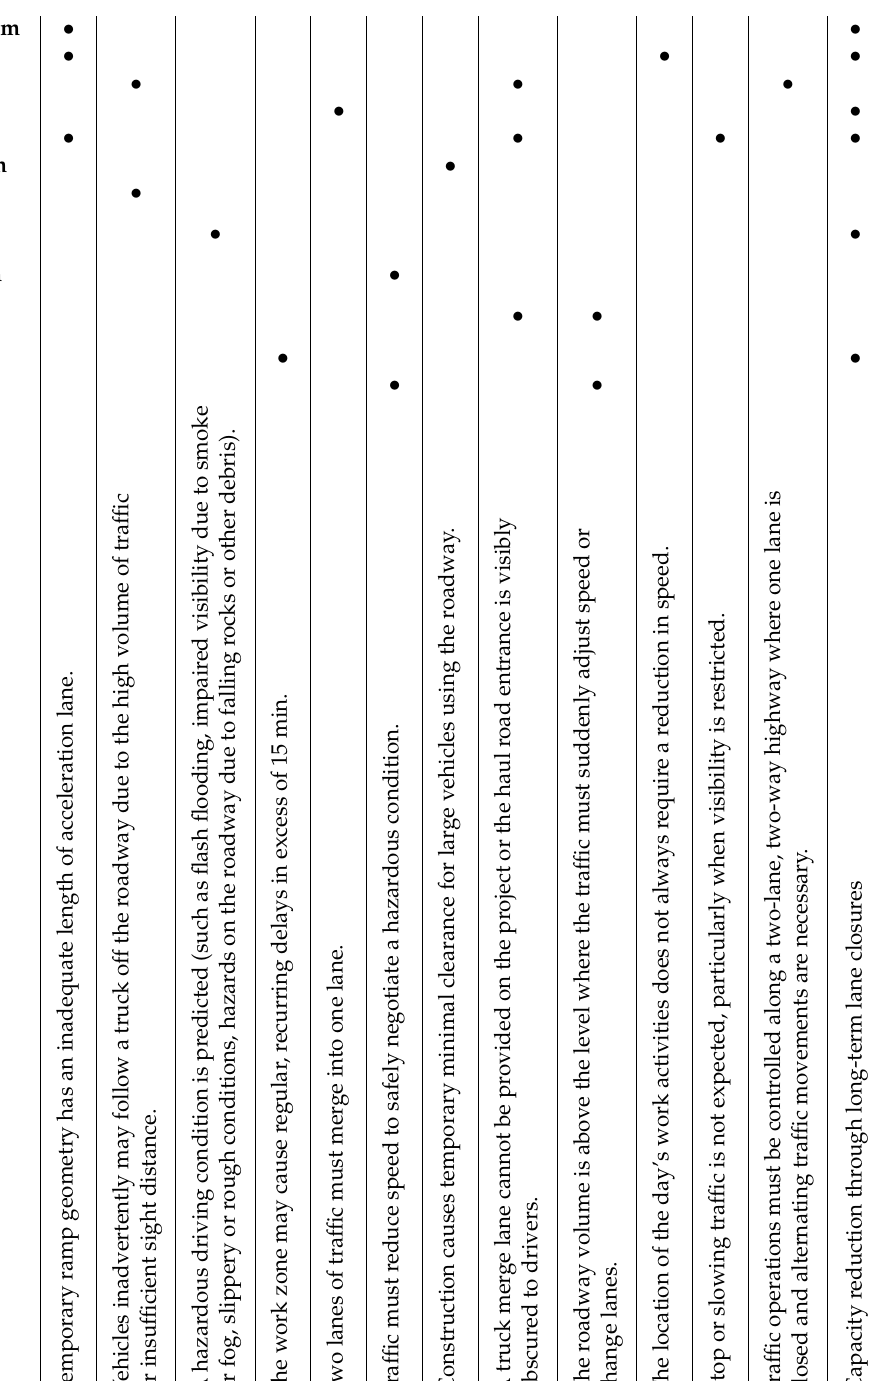
Table 4. Critical project characteristics in a work